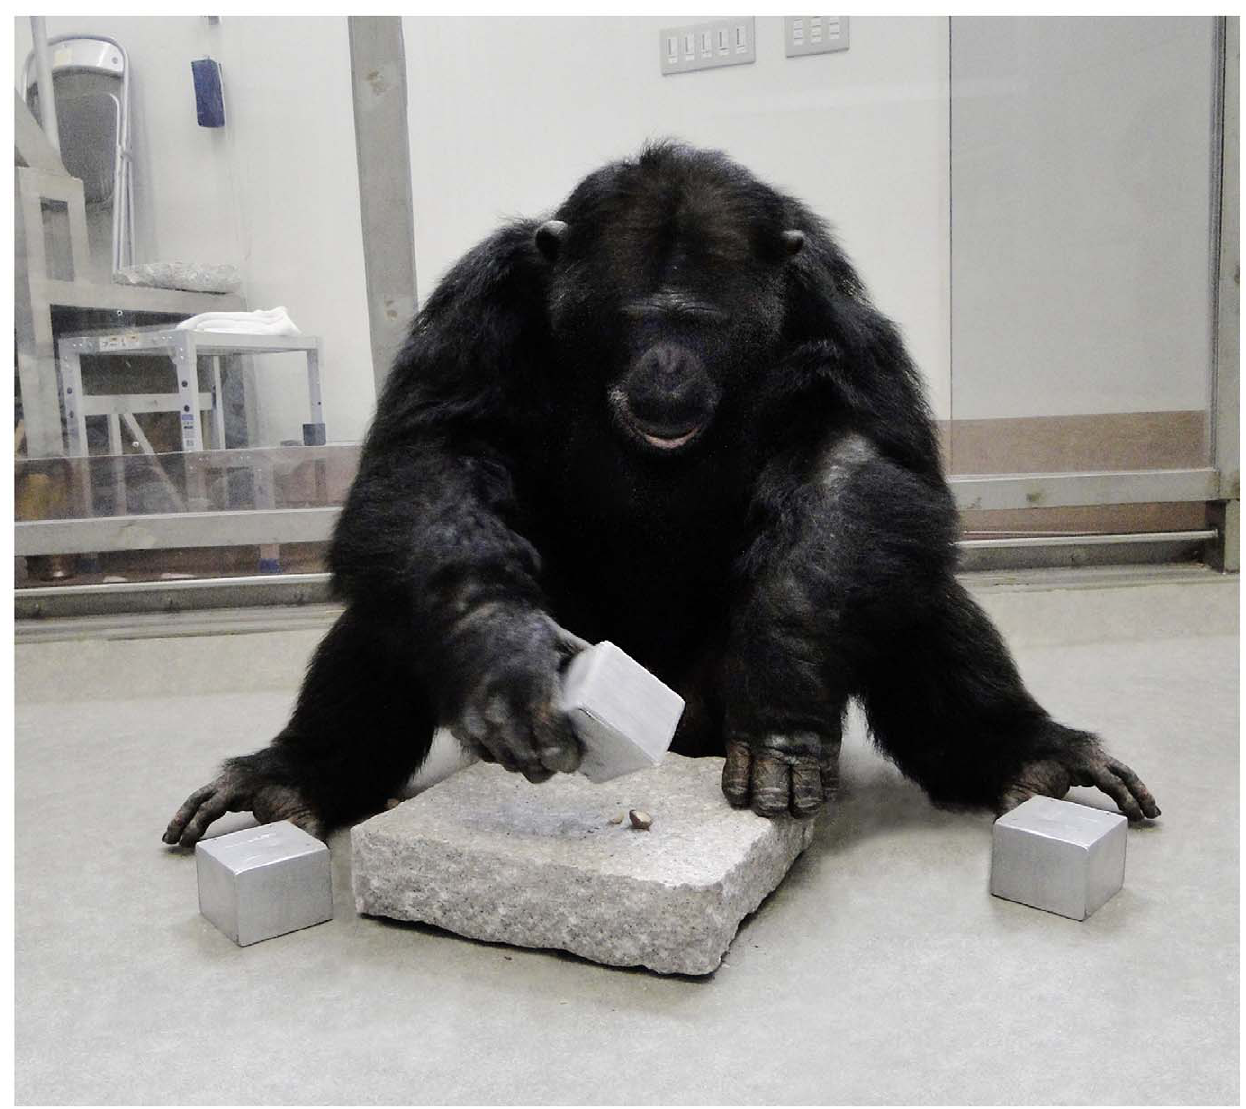
Figure 1. A chimpanzee using a cuboid-shaped hammer to crack open a nut in a pit of the anvil.